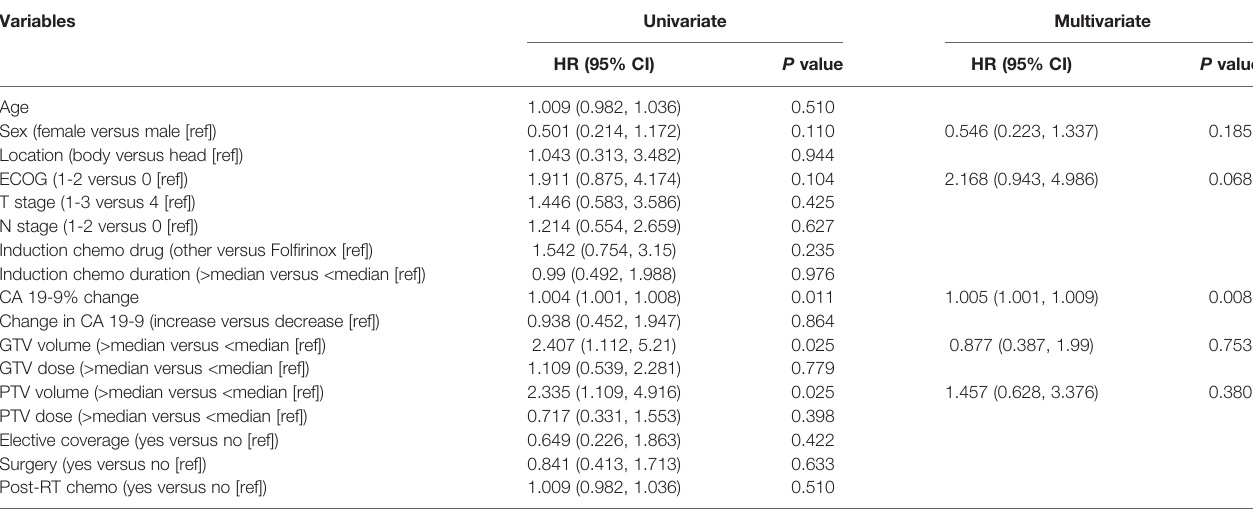
TABLE 3 | Multivariate analyses of factors predicting for overall